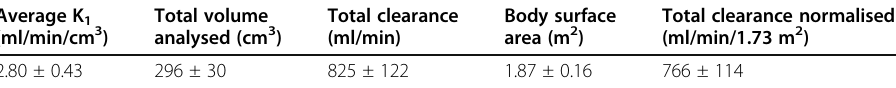
Table 5 Estimation of total renal clearance based on 82 Rb clearance values (K 1 ) using AA activity in